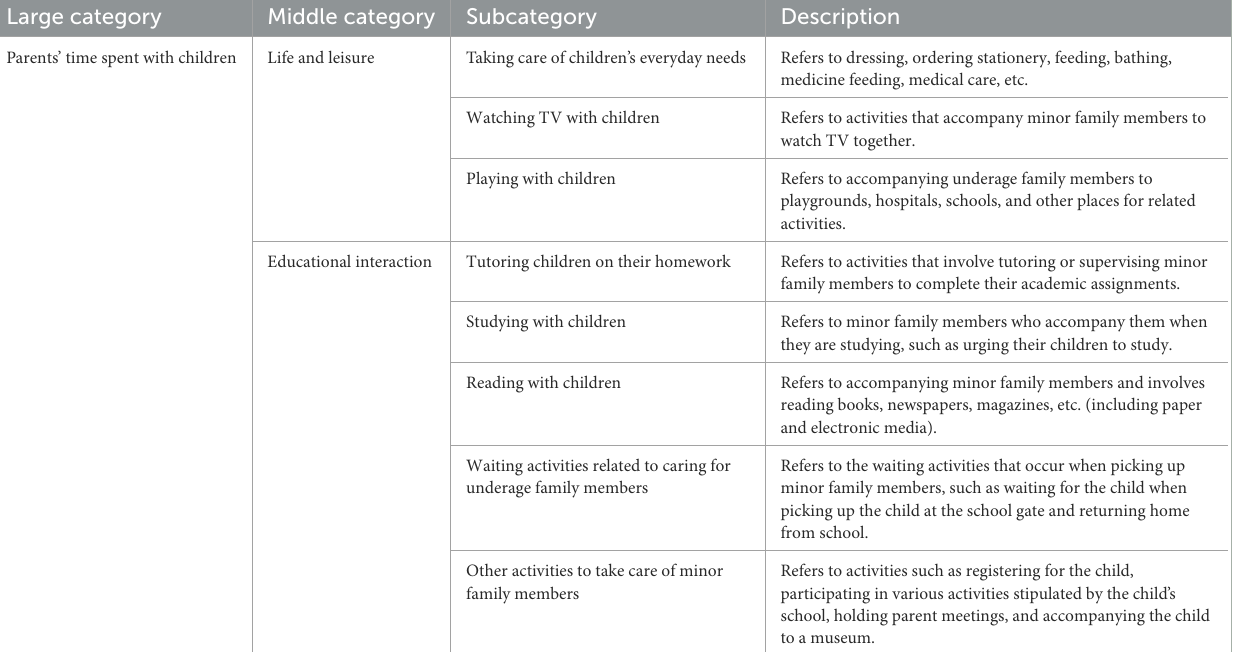
TABLE 1 Specific classification of parental companionship activities. Large